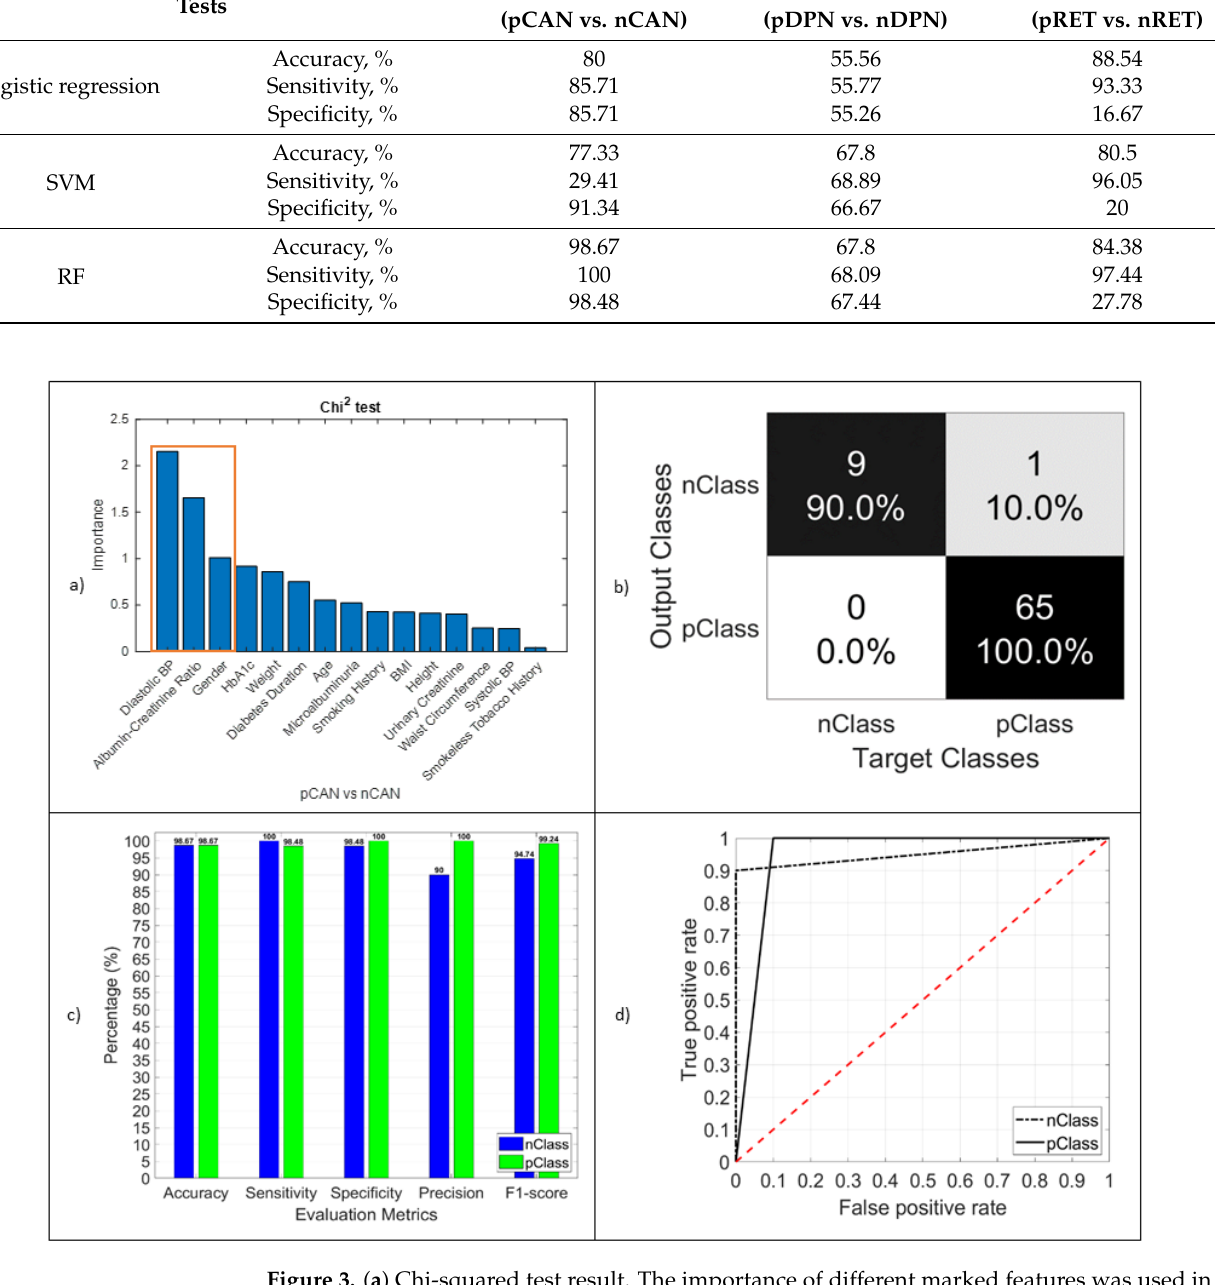
Figure 3. ( a ) Chi-squared test result. The importance of different marked features was used in the model as an identifier; ( b ) confusion matrix of the CAN test (pClass vs. nClass); ( c ) performance evaluation matrices; ( d ) TPR vs. FPR, graphical view of the CAN classifier model performance.